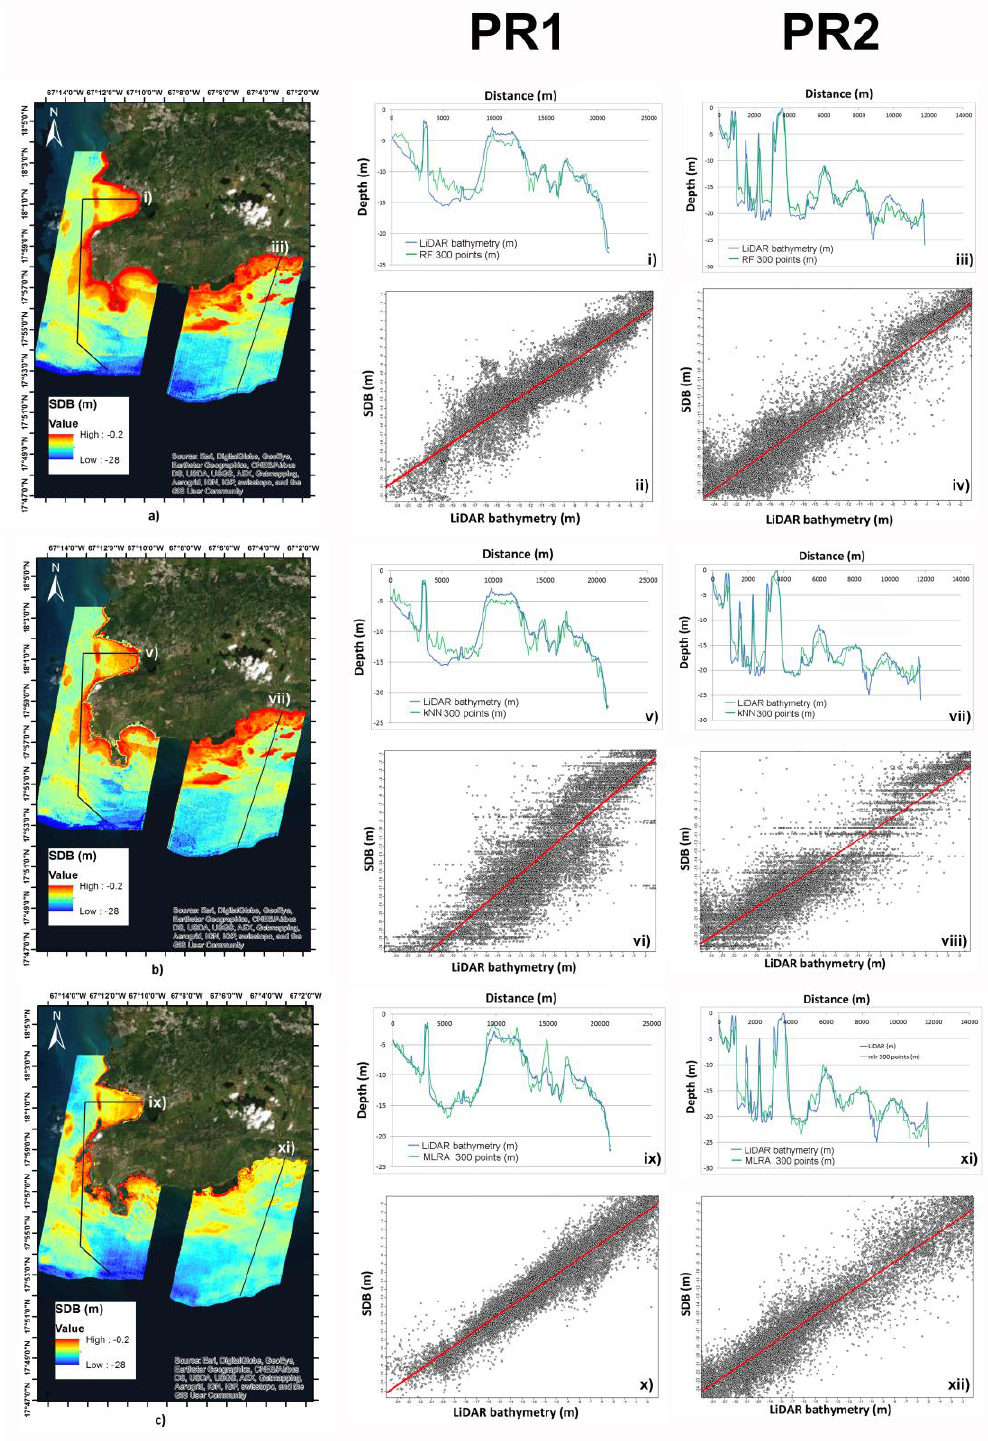
Figure 3. Satellite-derived bathymetry from stage 1 using (a) the random forest (RF), (b) the kappa nearest neighbor (kNN), and (c) the multiple linear regression analysis (MLRA) algorithms. PR1: Bathymetric profile comparison and scatterplot between airborne laser bathymetry and SDB using: RF (i),(ii); kNN (v),(vi) and MLRA (ix),(x). PR2: Bathymetric profile comparison and scatterplot between airborne laser bathymetry and SDB using: RF (iii),(iv); kNN (vii),(viii) and MLRA (xi),(xii).